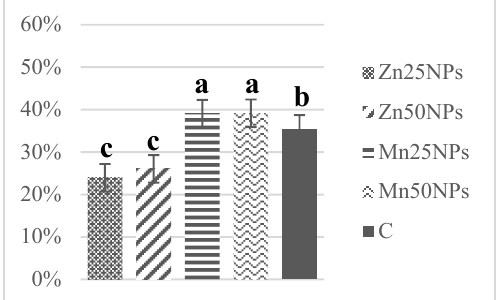
Figure 9. Percentage of turkey sperm producing NO (%) in samples stored for 48 h with or without